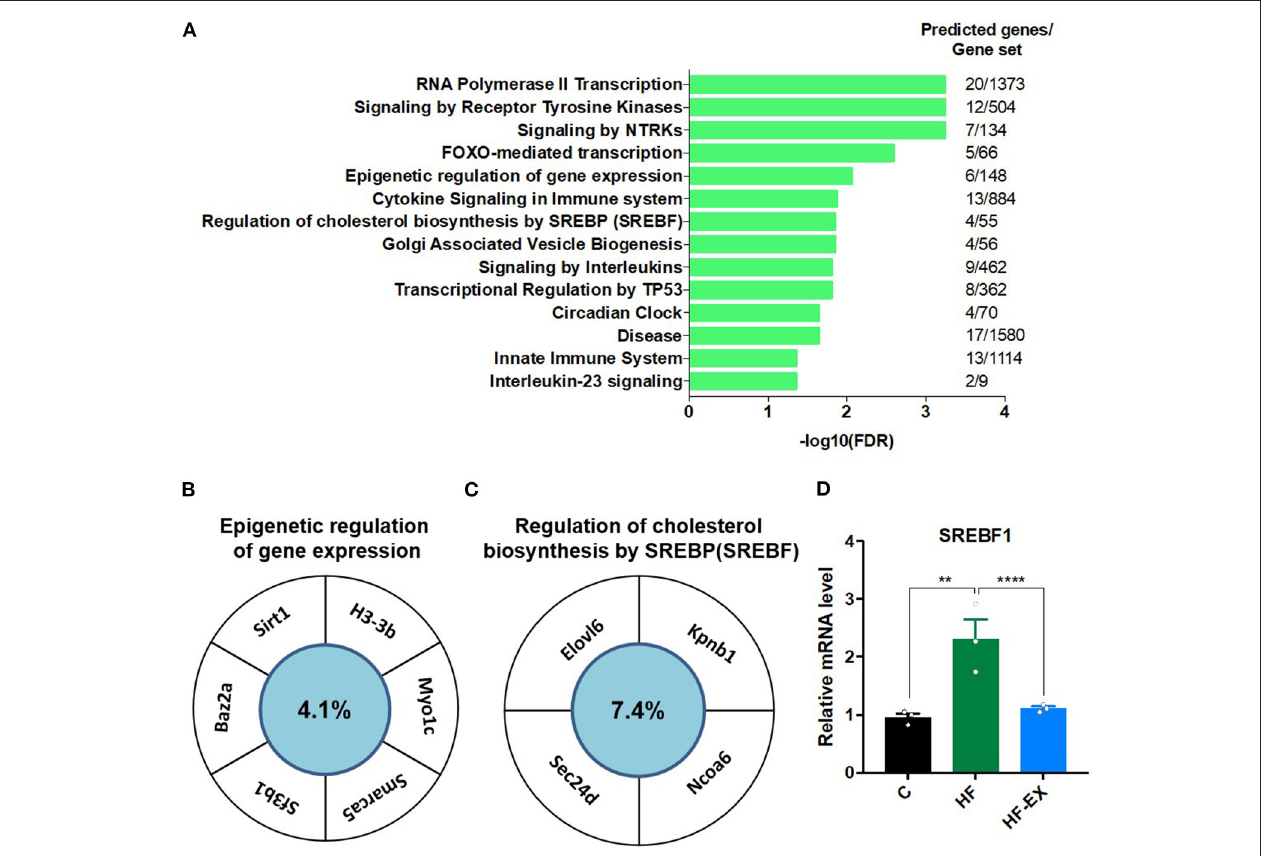
FIGURE 6 | Analysis of the targeted genes of the differentially expressed hepatic miRNAs in adult offspring regulated by maternal exercise. (A) Reactome pathway enrichment analysis of the target genes; (B) genes enriched in the epigenetic regulation of gene expression pathway; and (C) target genes involved in the regulation of cholesterol biosynthesis by SREBP pathway; (D) SREBF1 expression level. C, offspring of dams fed the normal control diet; HF, offspring of dams fed the high-fat diet; HF-EX, offspring of dams intervened with a high-fat diet and exercise; SREBF1, sterol regulatory element binding protein-1. Data are expressed as means ± SD ( n = 3/group). Mean values were significantly different between the groups: ** p < 0.01, **** p <